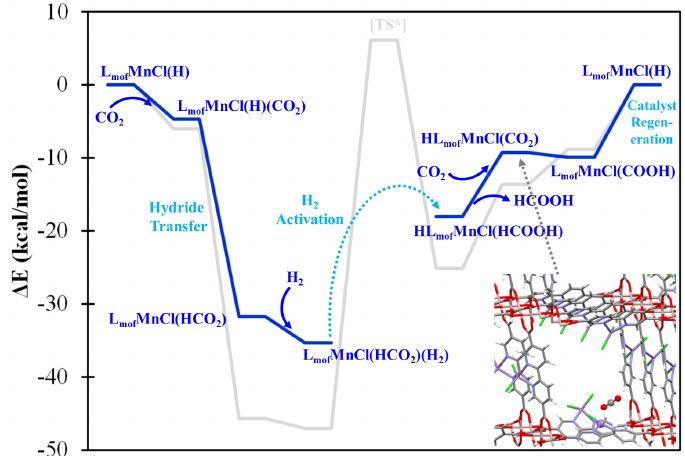
Figure 6. The predicted catalytic mechanism (blue lines) of formic acid generation by L mof MnCl(H) catalytic site with H 2 (g) + CO 2 (g). The gray lines denote the mechanism of the molecular model. [TS*] denotes the approximate transition state.